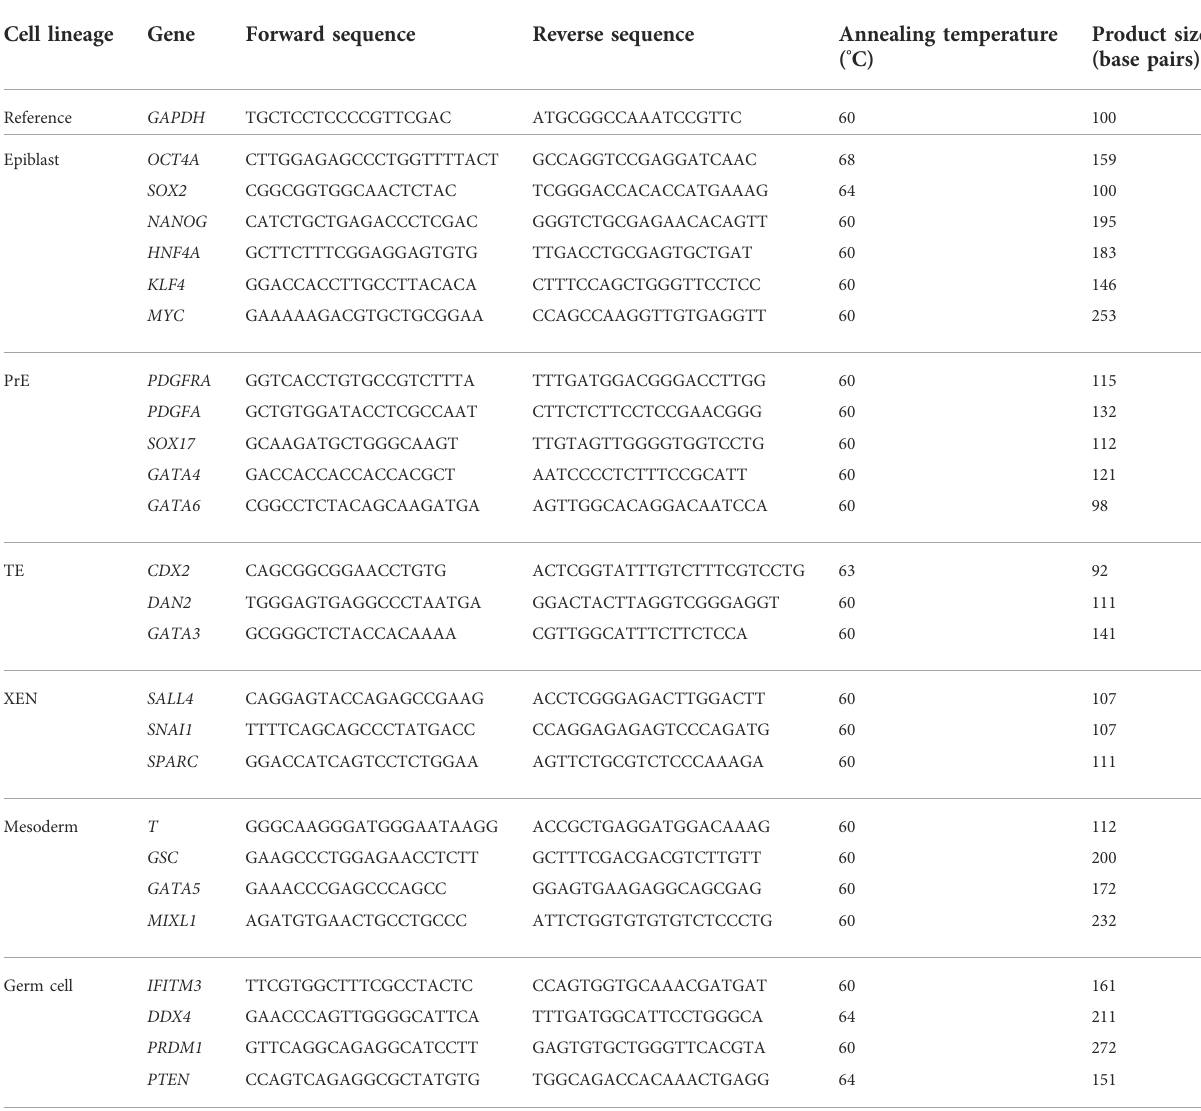
TABLE 2 List of oligonucleotides for quantitative PCR. Cell